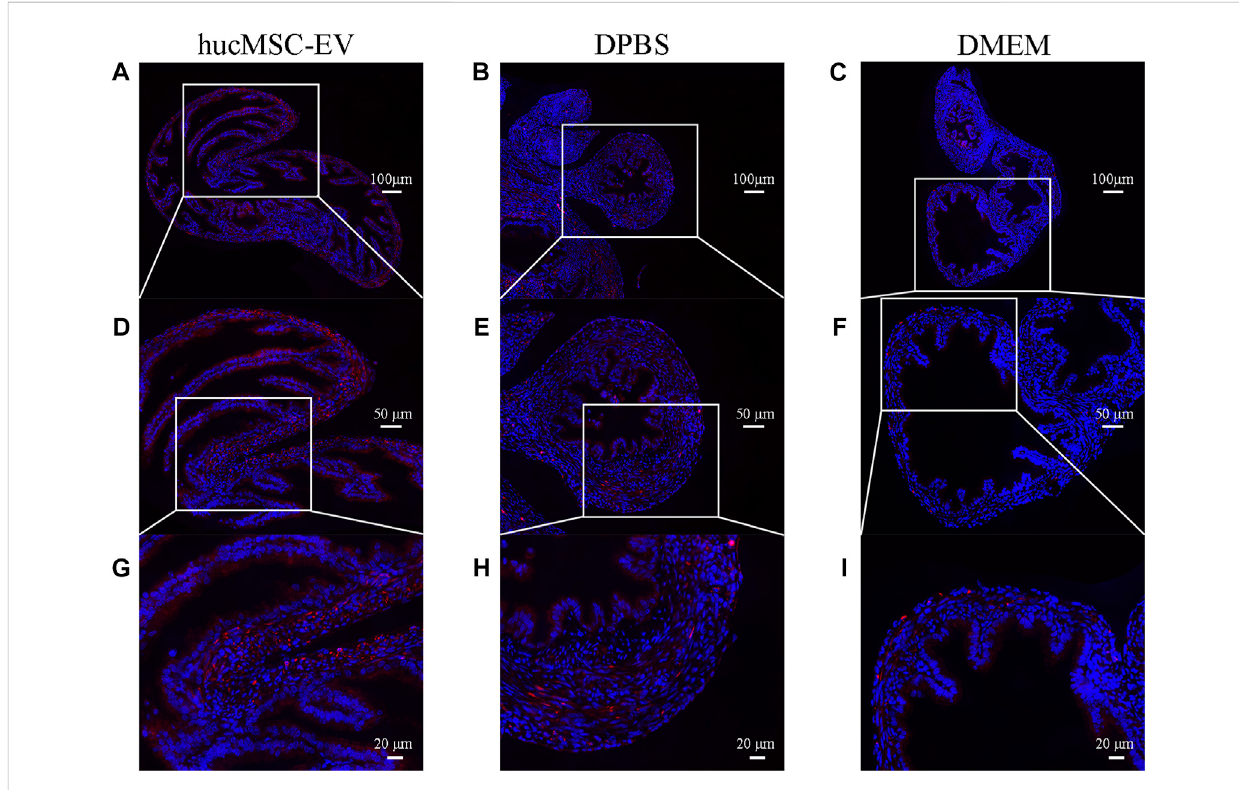
FIGURE 4 Immuno fl uorescence of CD206 showing M2 macrophages in the murine fallopian tubes in each experimental group (A-I) . Immuno fl uorescence of CD206 (red) showing M2 macrophages in the murine fallopian tubes in hucMSC-EV group (A, D, G) , DPBS group (B, E, H) , and DMEM group (C, F, I)